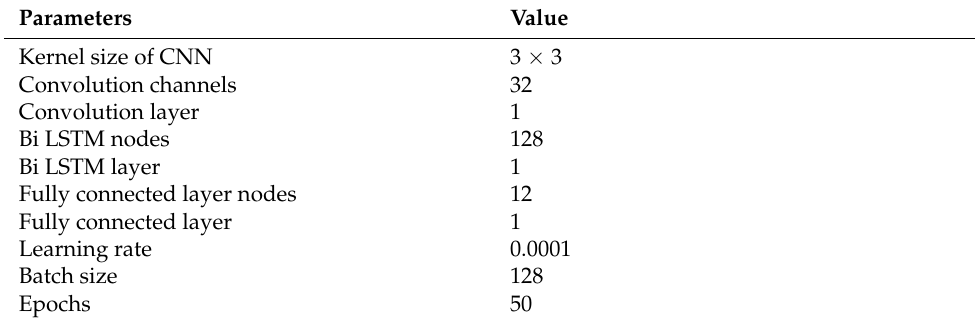
Table 2. CBAM-CNN-Bi LSTM model parameters